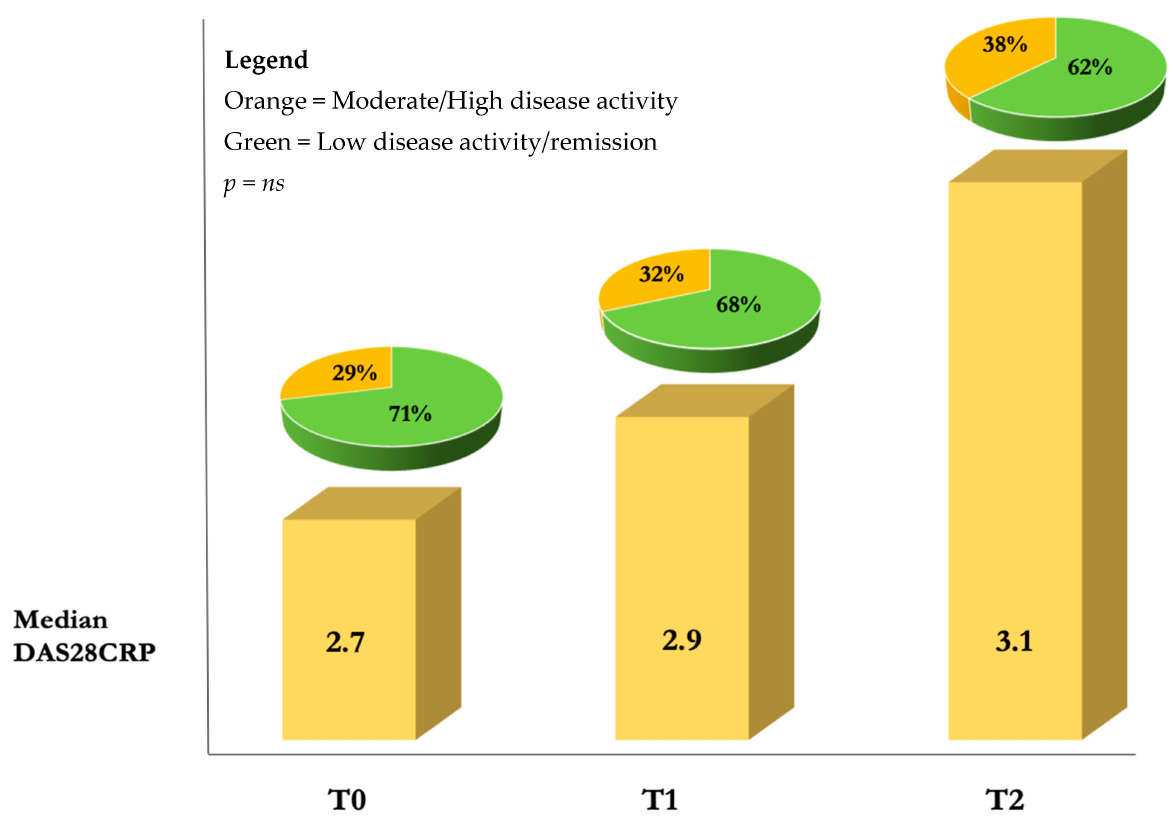
Figure 2. Disease activity score in the rheumatoid arthritis patients at baseline and during the